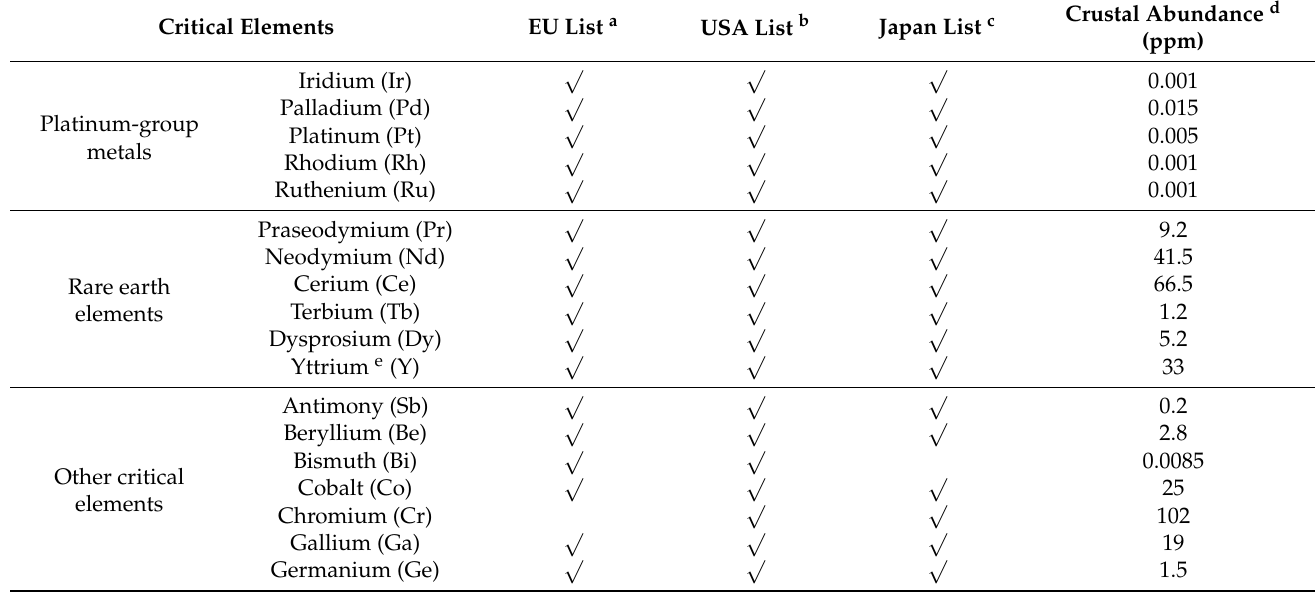
Table 1. Table of critical elements and raw materials with economic importance considering the EU list, US List and Japan List and their crustal